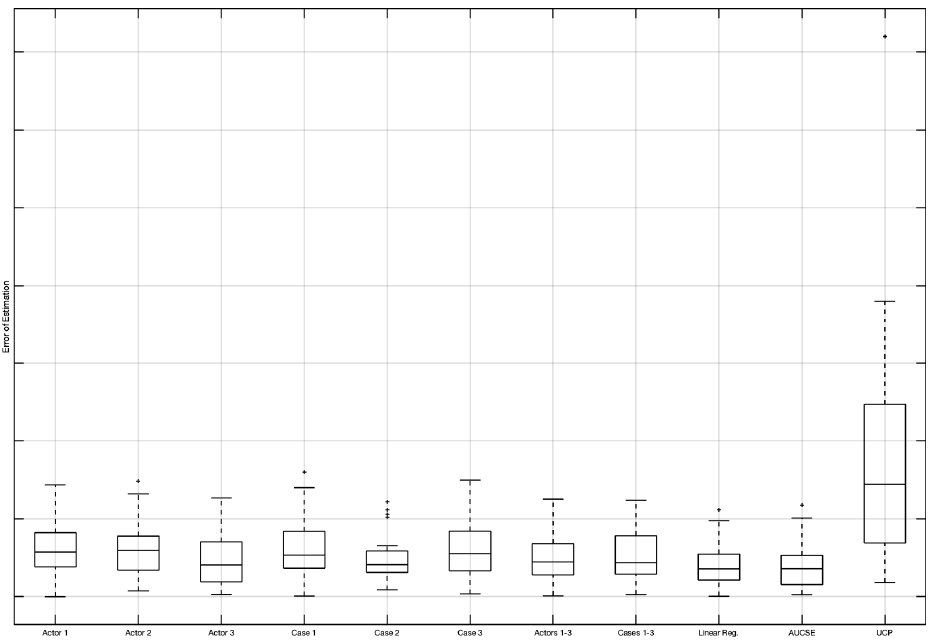
Figure 16. Comparison of absolute residuals for linear regression model variants.